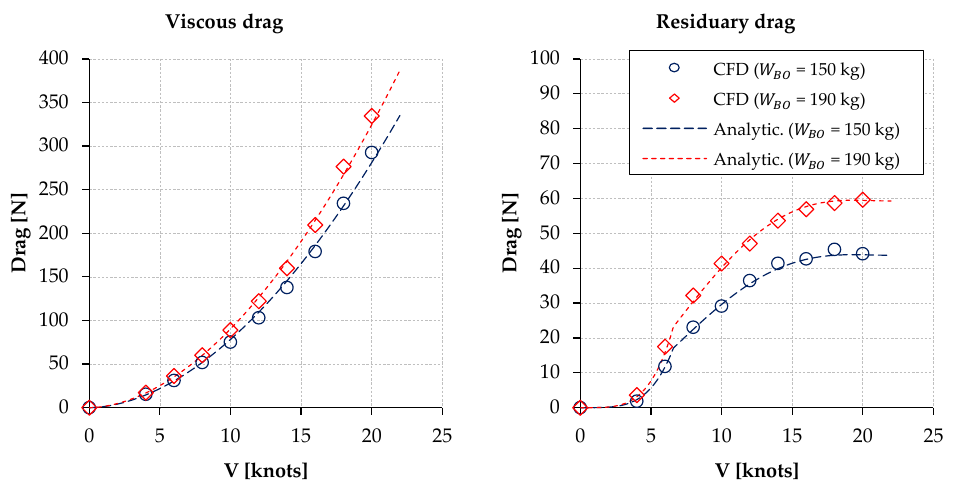
Figure 7. CFD and modelled drag breakdown for the reference demihull.